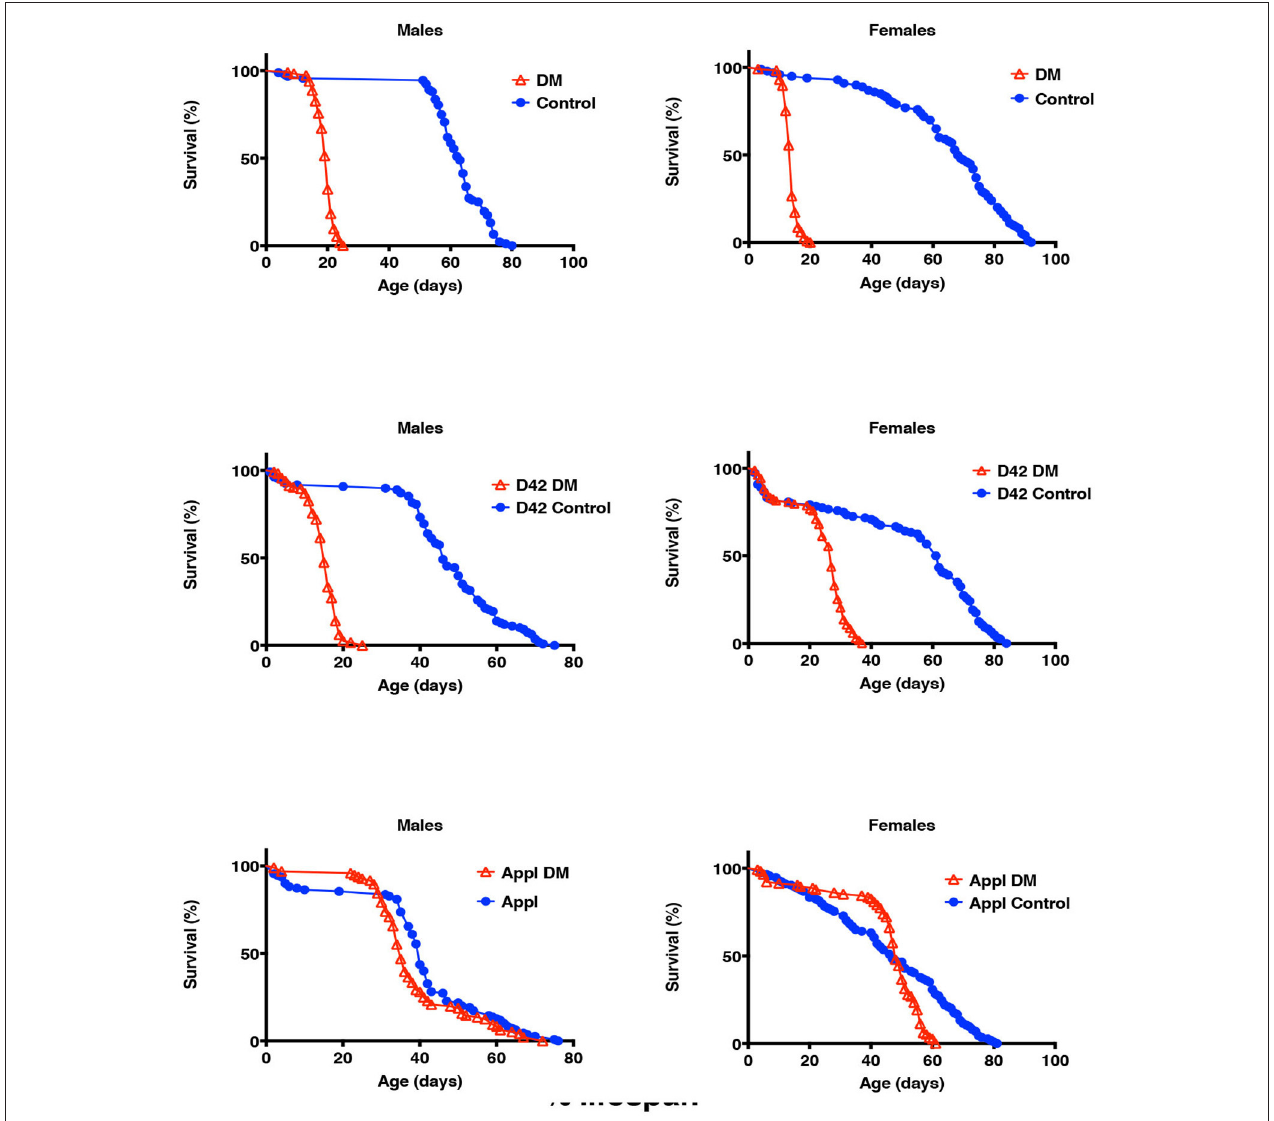
FIGURE 1 | Effects of under-expression of mitochondrial Prxs on fly life spans. dPrx3 was under-expressed in dprx5 null background globally with Da-GAL4 driver (DM), pan-neuronally with Appl-GAL4 driver (Appl DM) and in motor neurons with D42-GAL4 driver (D42 DM). Approximately 100–125 flies were used for each fly line. Shown are representative data of two independent biological experiments. Similar results were obtained in the biological replicate experiment. The data are summarized in Table 2 . The names of fly lines and genotypes of flies are described in Table 1